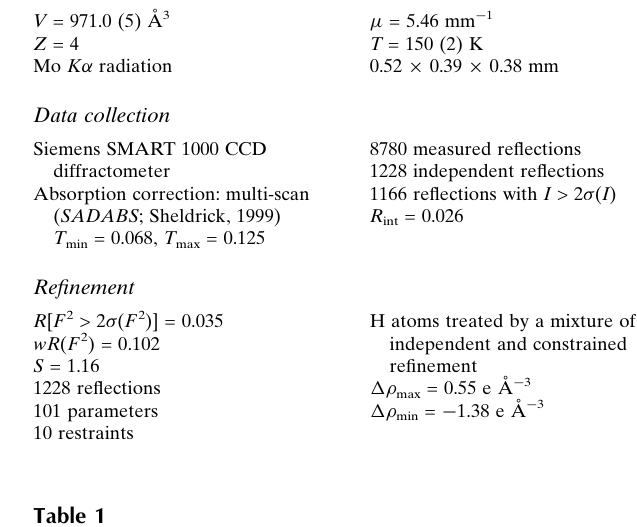
Selected bond lengths (A˚ ).